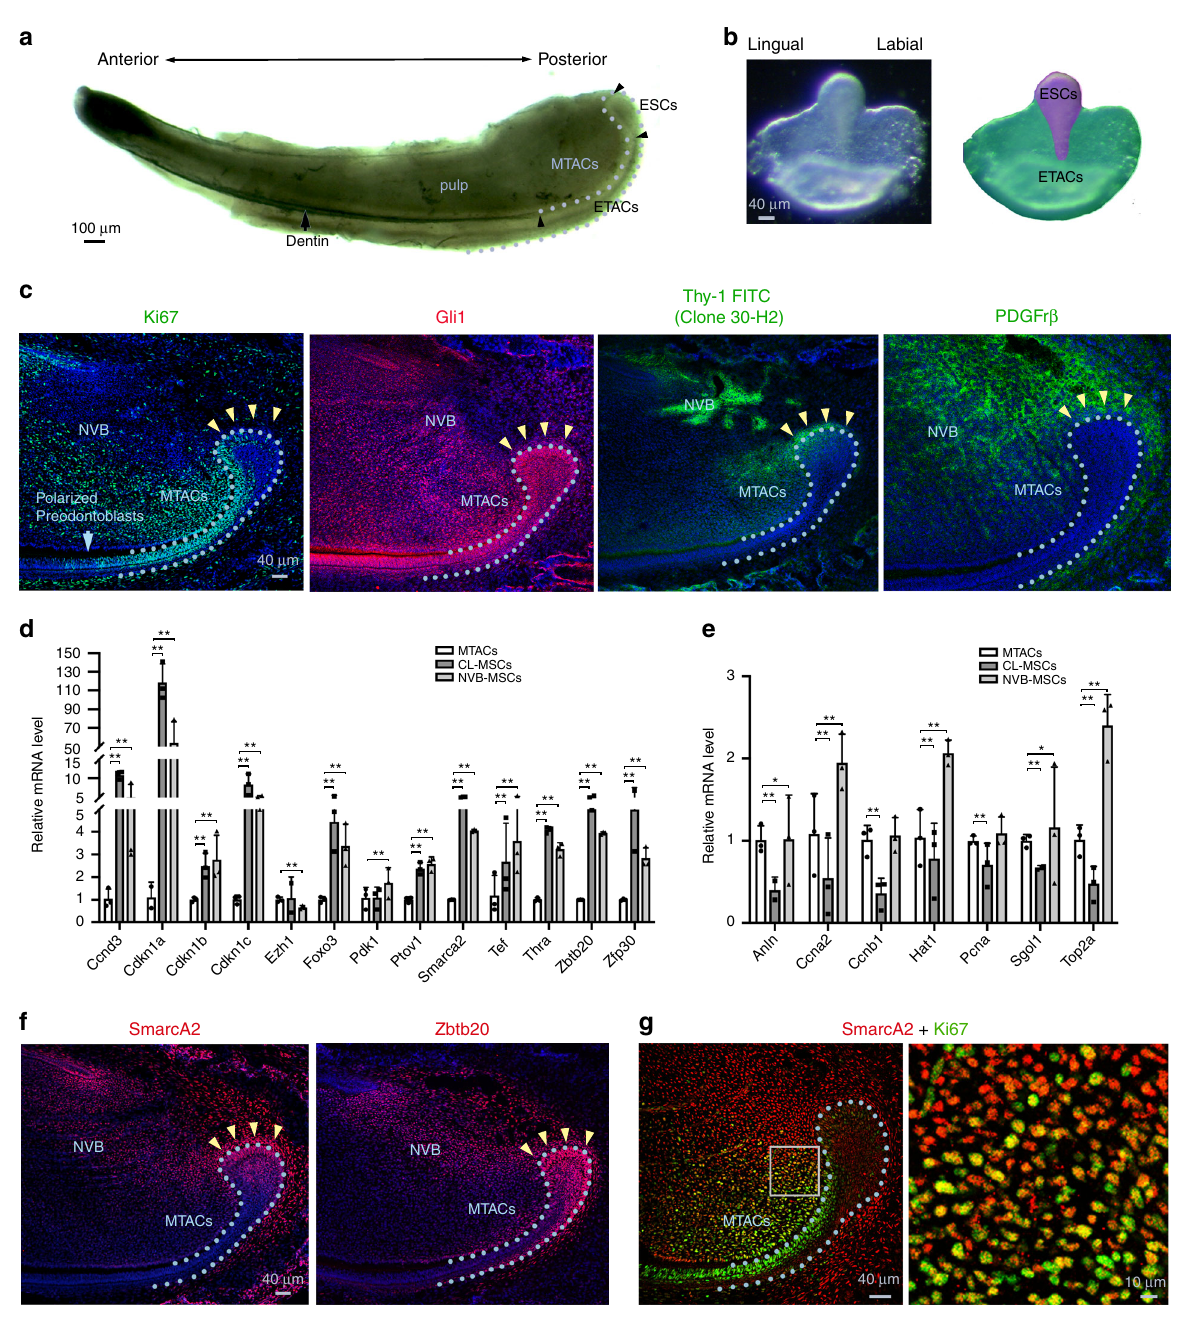
Fig. 1 Identi fi cation of the CL-MSCs in the mouse incisor tooth. a Whole view of one P7 mouse lower incisor. Black arrowheads show approx. boundaries of indicated epithelial cells zones: ESCs epithelial stem cells, ETACs epithelial transit amplifying cells, MTACs, mesenchymal transit amplifying cells, and dentin layer. Light blue dotted line indicates epithelial – mesenchymal junction. b Stereo front view of a P7 incisor CL epithelium (left) and arbitrarily colored indexes for the ESCs (purple) and ETACs (green) regions (right). c Immuno fl uorescence analysis of indicated antigenic markers in P7 incisors. Nuclei were counterstained with DAPI. Light blue dotted line shows epithelial – mesenchymal junction while yellow arrowheads indicate the mesenchymal cells named CL-MSCs. NVB neurovascular bundle region. d , e Gene expression pro fi ling using real time RT-PCR analysis on laser captured MTACs, CL-MSCs, and NVB-MSCs from n = 5 biologically independent animals, using two panels of general MSCs ( d ) and MTACs ( e ) markers. Triplicated samples were used for each gene. Error bars represent standard deviation. Statistical analysis was performed with two-way ANOVA followed by Bonferoni correction. No asterisk: p > 0.05; one asterisk: p < 0.05; two asterisks: p < 0.01. f , g Immuno fl uorescence analysis using indicated markers. In g , squared region in the right panel is enlarged in the left one. Note the overlapped expression of SmarcA2 and Ki67 at the junction of CL-MSCs and MTACs. Light blue dotted line shows epithelial – mesenchymal junction while yellow arrowheads indicate the mesenchymal cells named CL-MSCs. Bars: a : 100 μ m; b , c , f , g (left panel): 40 μ m; g (right panel): 10 μ